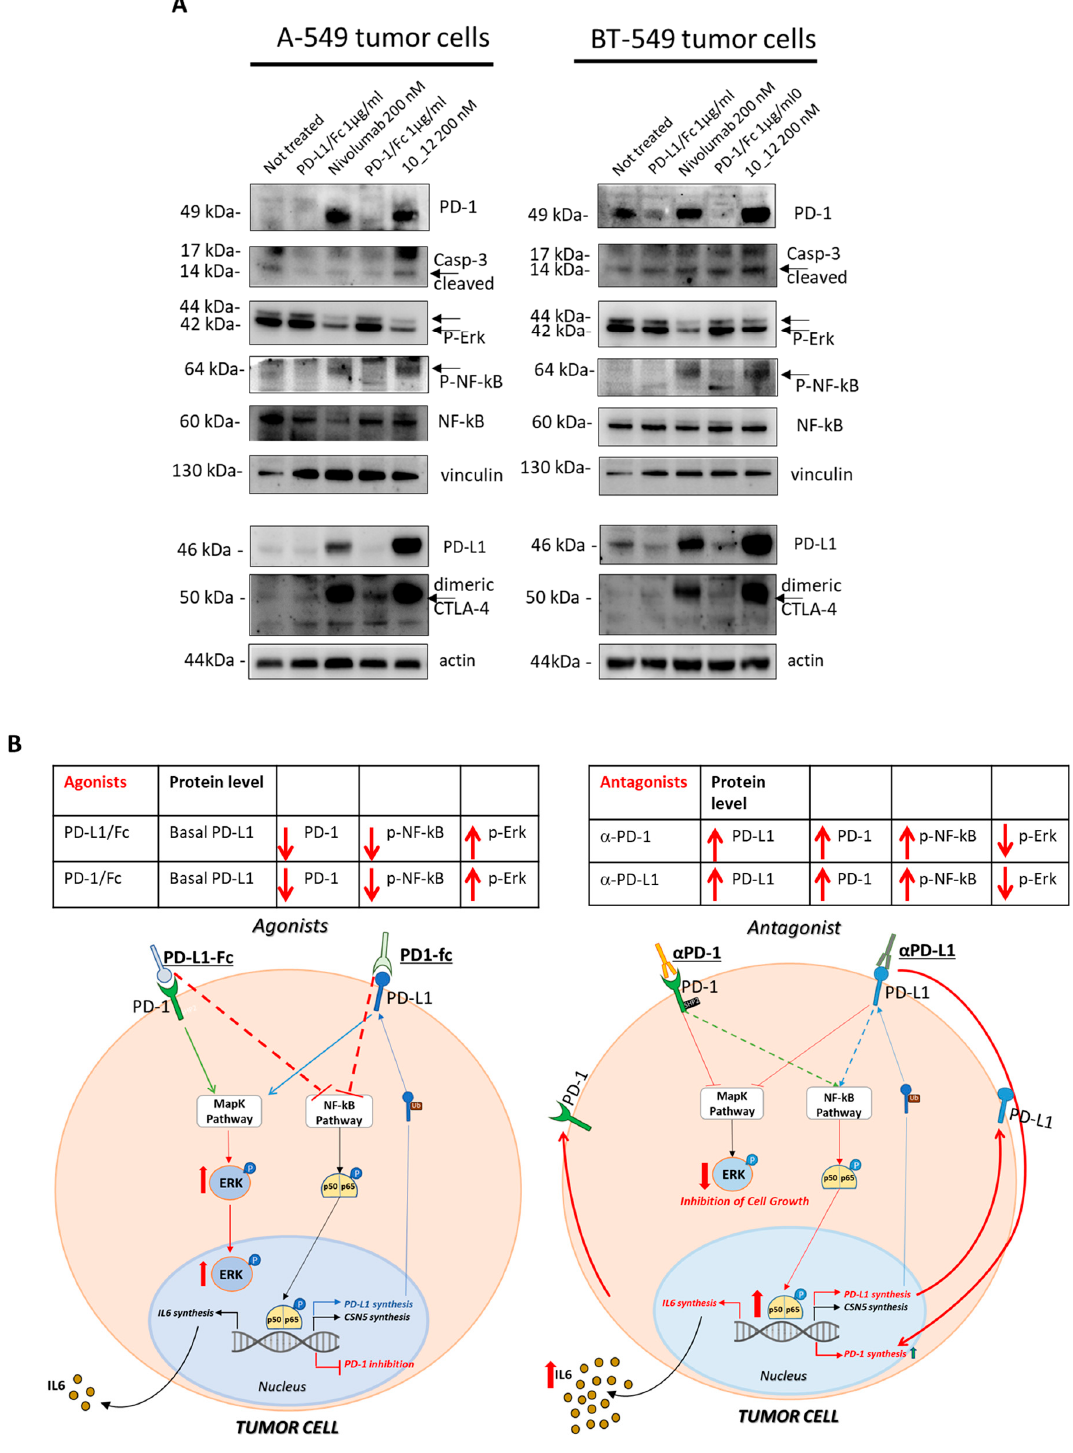
Figure 3. Effects of agonists and antagonists of PD-1 and PD-L1 on tumor cells. ( A ) Western blotting analyses of cell extracts from A-549 or BT-549 tumor cells, treated for 72 h with PD-1/PD-L1 agonists (PD-1/Fc or PD-L1/Fc) or antagonists (Nivolumab or 10_12 mAbs). Images of the whole Western blots are included in Figure S5. The intensity of the bands was normalized to vinculin or actin. ( B ) Model proposed to explain the effects of agonists or antagonists of PD-1 and PD-L1 on tumor cells and on their intracellular pathways.